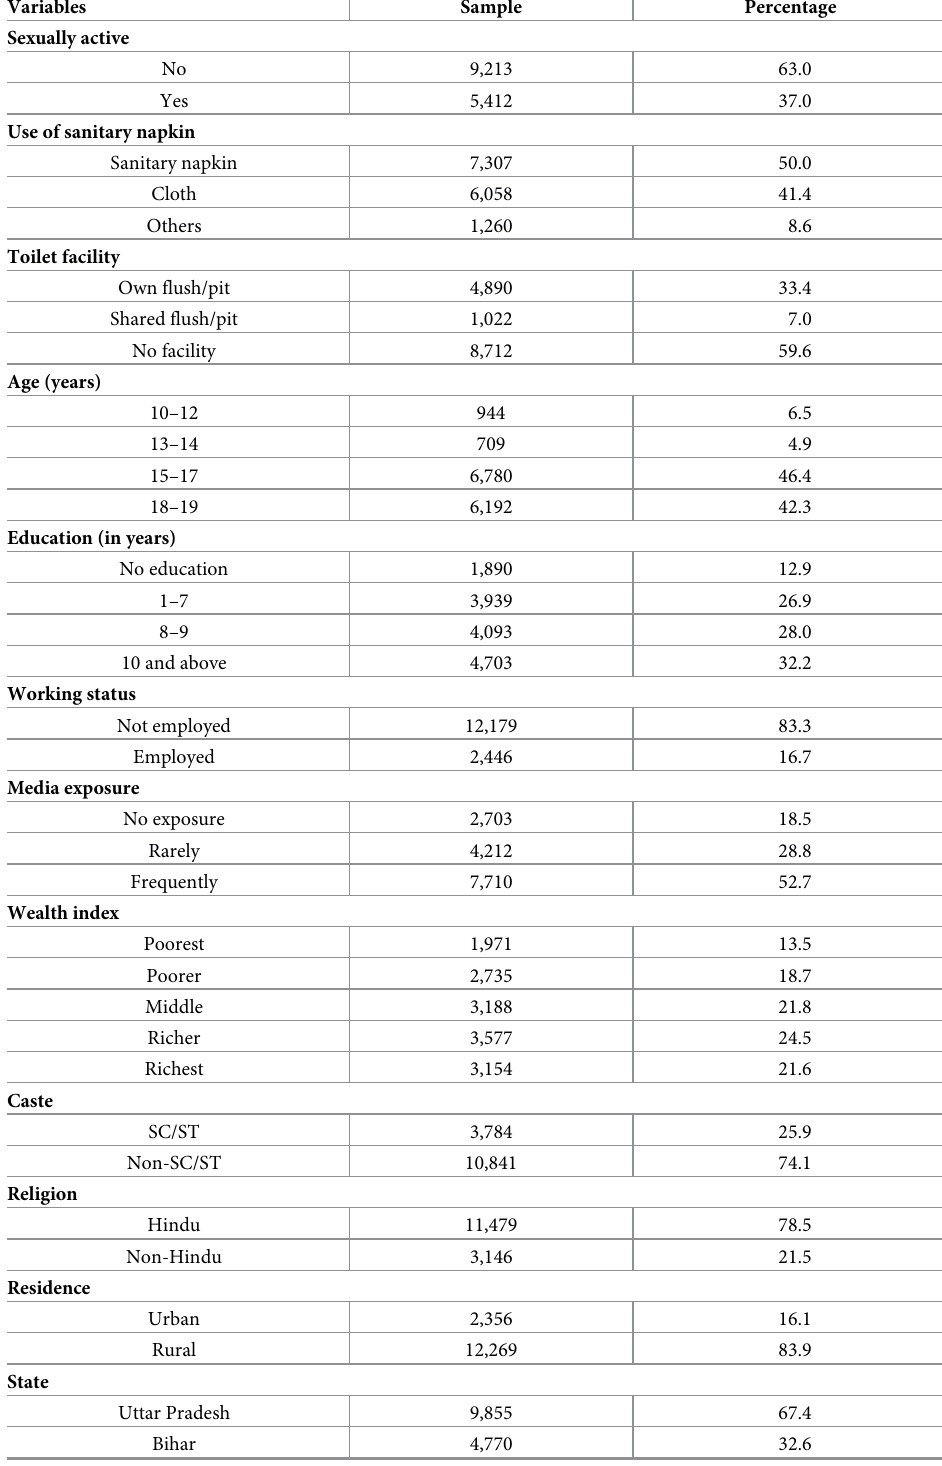
Table 1. Demographic and socio-economic profile of adolescent girls aged 10–19